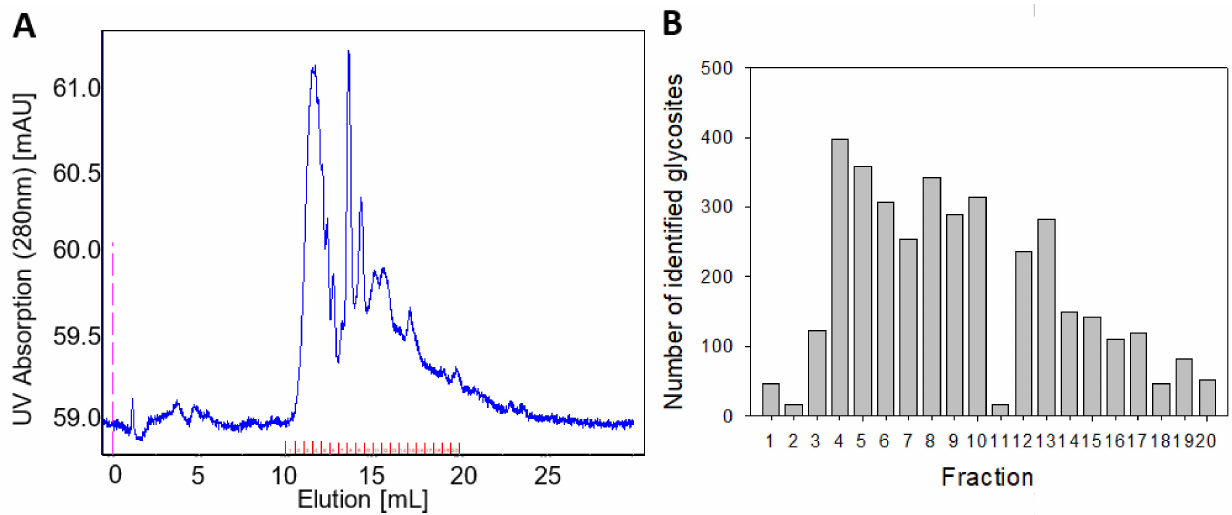
Figure 1. Glycopeptide separation by size exclusion chromatography (SEC) (100–7000 Da). ( A ) Chromatogram includes UV-spectrum at 280 nm (blue) and collected fractions (red). ( B ) Number of identified glycosites with high localization probability (>0.75) in each